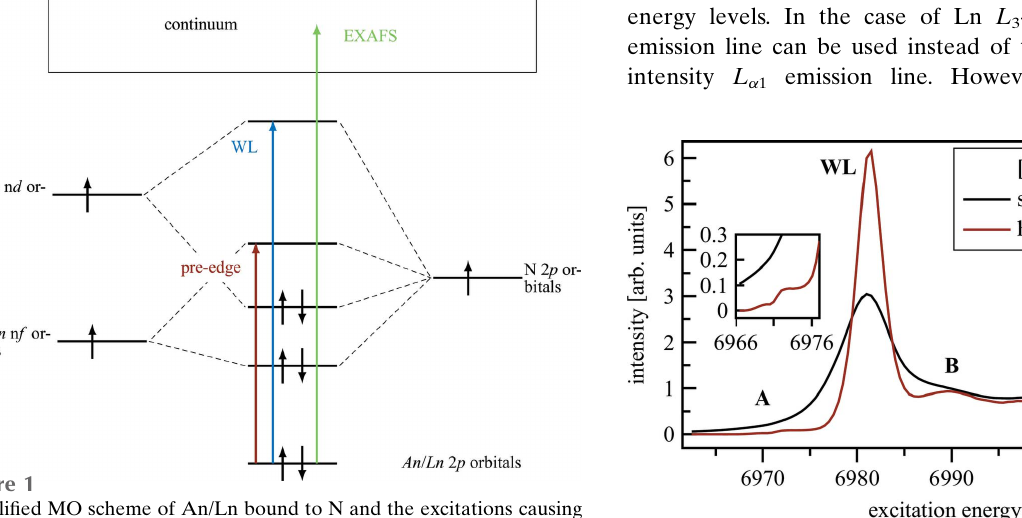
Figure 2 Standard and HR-XANES of [Eu( n -Pr-BTP) 3 ](OTf) 3